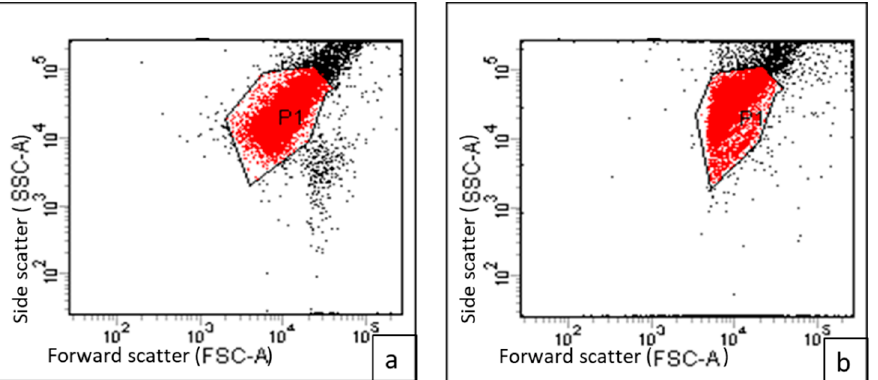
Figure 6. A representative flow cytometric chart (dot plot) showing the fluorescent gap ( a ) before (95.7%) and ( b ) after (22.8%) treatment with CRME measured by FACS verse flow cytometer.